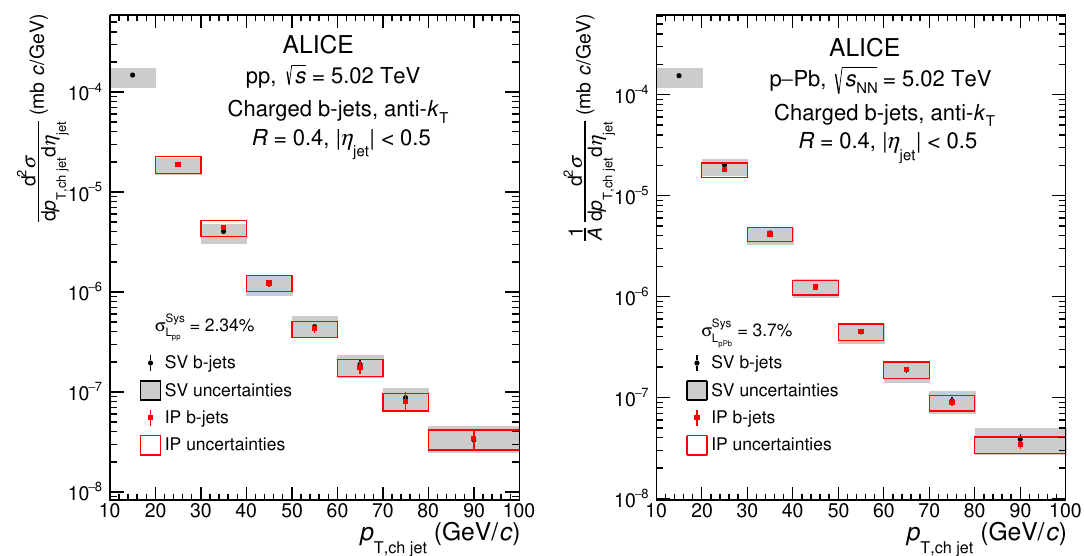
Figure 11. Comparison of the p T differential production cross section of charged-particle anti- k T R = 0 . 4 b jets measured in pp and p-Pb collisions at methods. Systematic and statistical uncertainties are shown as boxes and error bars respectively. The additional common normalization uncertainty due to luminosity is denoted σ Sys